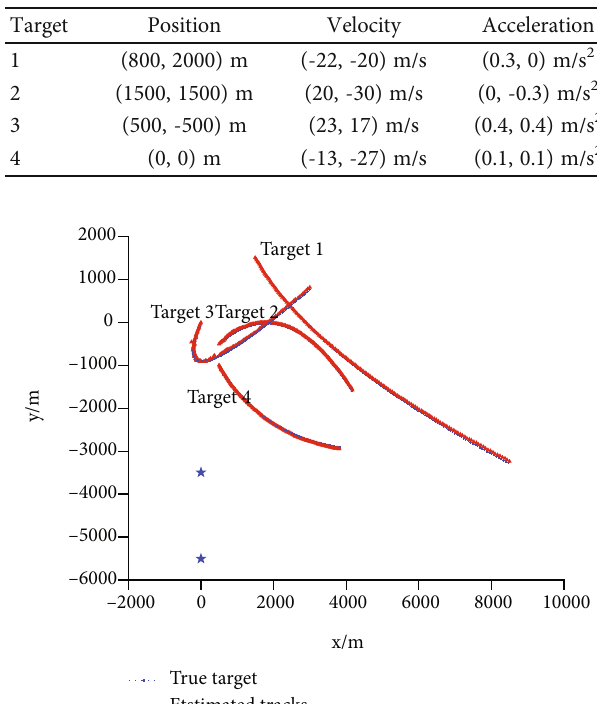
Table 5: The fi ve targets ’ initial position and